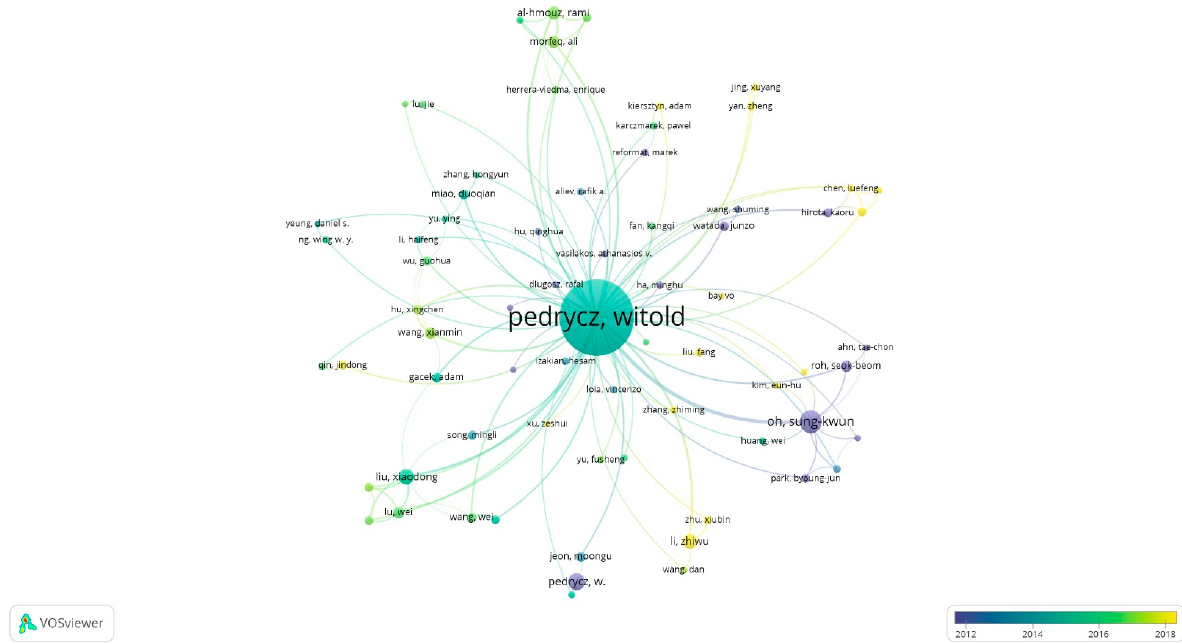
Figure 19. Citation report for 1001 results from the Web of Science Core Collection by the author Witold Pedrycz. Figure 20 was calculated in VOSviewer and represents the relationship o f au- thors with Witold Pedrycz in the area of fuzzy clustering. The graph was made con- sidering the global work with a total of 1001 publications collected from Web of Science.